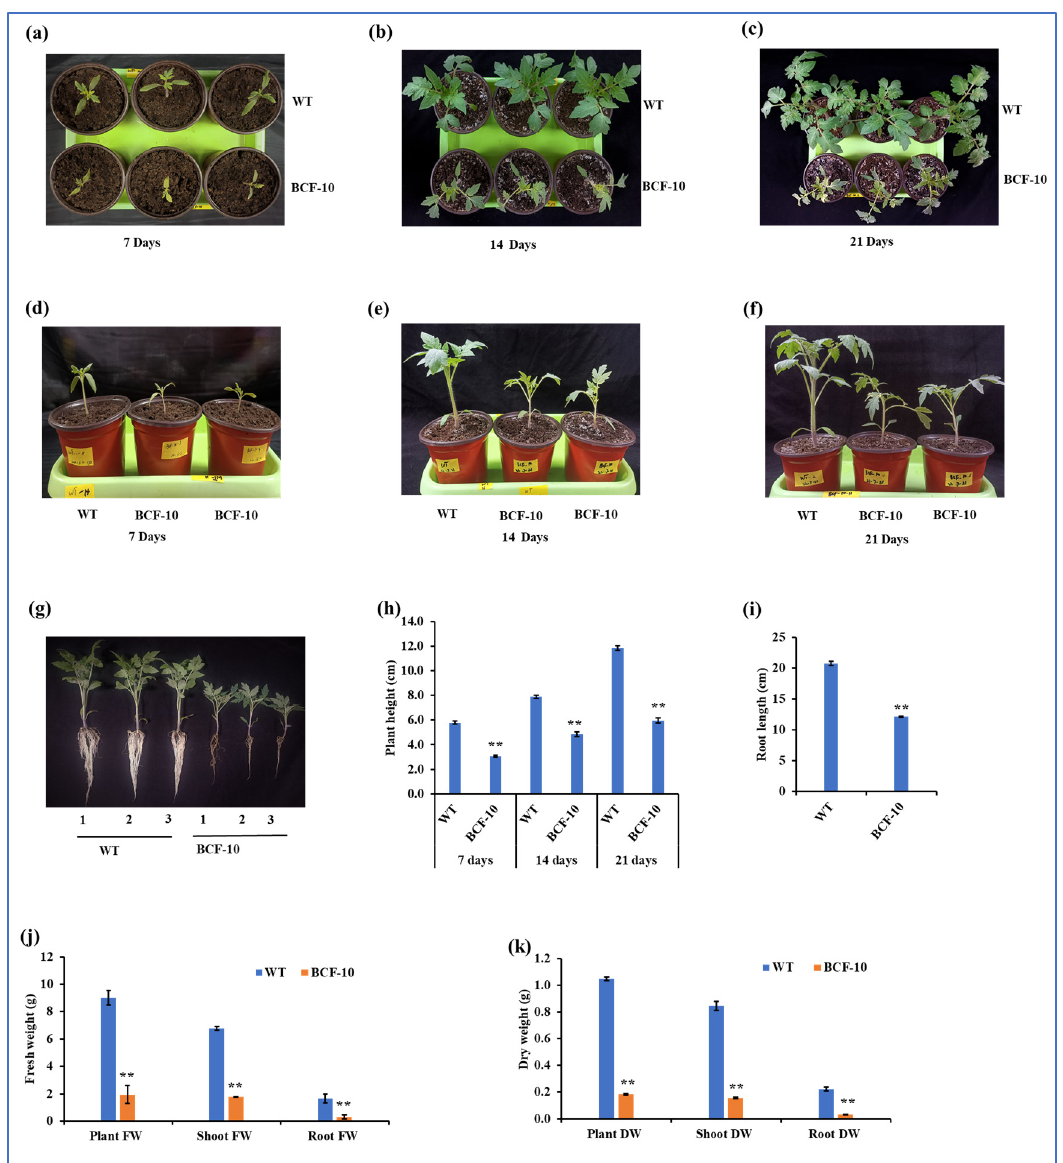
Figure 5. Phenotypical and morphological characterization of WT and BCF overexpression plants under HL growth conditions. ( a – c ) Images showing the growth of WT and BCF-OE tomato plants grown at HL growth conditions for 7, 14, and 21 days. ( d – f ) Plant height of WT and BCF-OE plants. ( g ) Root and shoot growth of 21-day-old WT and BCF-OE plants. ( h ) Plant height measurements. Plant height was measured from the base of the stem to the top of the plant. ( i ) Twenty-one-day-old plant root length, ( j ) plant fresh weight, shoot fresh weight, and root fresh weight, respectively. ( k ) Measurement of plant dry weight, shoot dry weight, and root dry weight. The data point is the average of six replicates, and SE represents the standard error. Asterisks indicate a significant difference compared to WT (Student’s t -test, ** p <